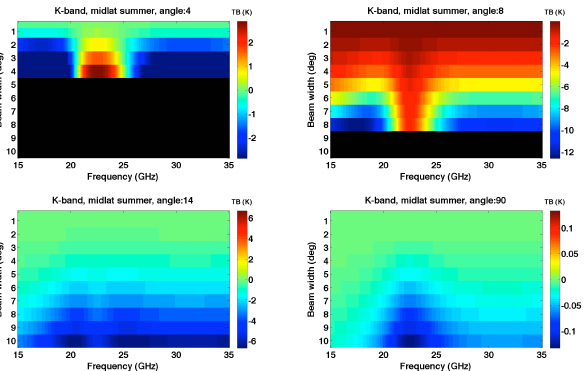
Fig. 12. Explanation of over and under estimations that cause the Figure 12. Explanation of over and under estimations that cause the beam width errors, which 5 beam width errors, which are linked to the curvature of the TB are linked to the curvature of the TB vs angle curve in K-band for the mid-latitude summer 6 vs. angle curve in K-band for the mid-latitude summer sounding. The vertical dotted lines represent the 10 ◦ beam width (centre line sounding. The vertical dotted lines represent the 10° beam width (center line is center angle). 7 is centre angle). The short horizontal dashed lines are used to lo- The short horizontal dashed lines are used to locate the intersection of the extremities of the 8 cate the intersection of the extremities of the beam width and the beam width and the dashed dot line locates the center angle on the TB curve. These additional 9 dashed dot line locates the centre angle on the TB curve. These ad- lines help to visually see that the over-estimation and under-estimation errors are linked to the 10 ditional lines help to visually see that the over-estimation and under- curvature of the TB curve. 11 estimation errors are linked to the curvature of the TB